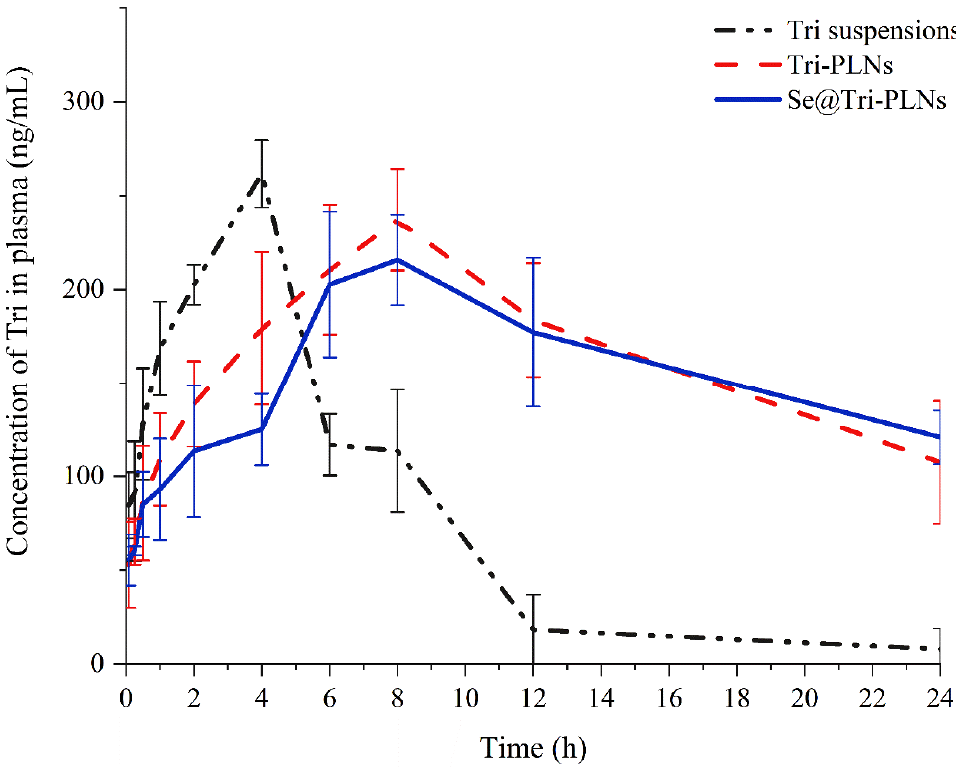
Figure 10. Plasma drug concentration vs. time profiles of Tri suspensions, Tri ‐ PLNs and Se@Tri ‐ PLNs in rats after oral administration with a dose of 40 mg/kg (mean ± SD, n = 5). Table 2. Main pharmacokinetic parameters after oral administration of Tri suspensions, Tri ‐ PLNs and Se@Tri ‐ PLNs in rats at a dose of 40 mg/kg.